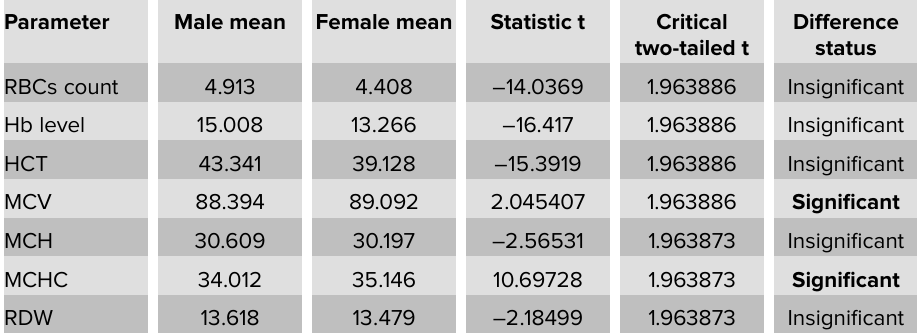
Figure 1: Diagram demonstrating RBCs count in male and female donors. *Population limitation is from the software. TABLE 2: The significance of the difference between male and female donors in regards to RBCs count, hemoglobin level, and hematocrit